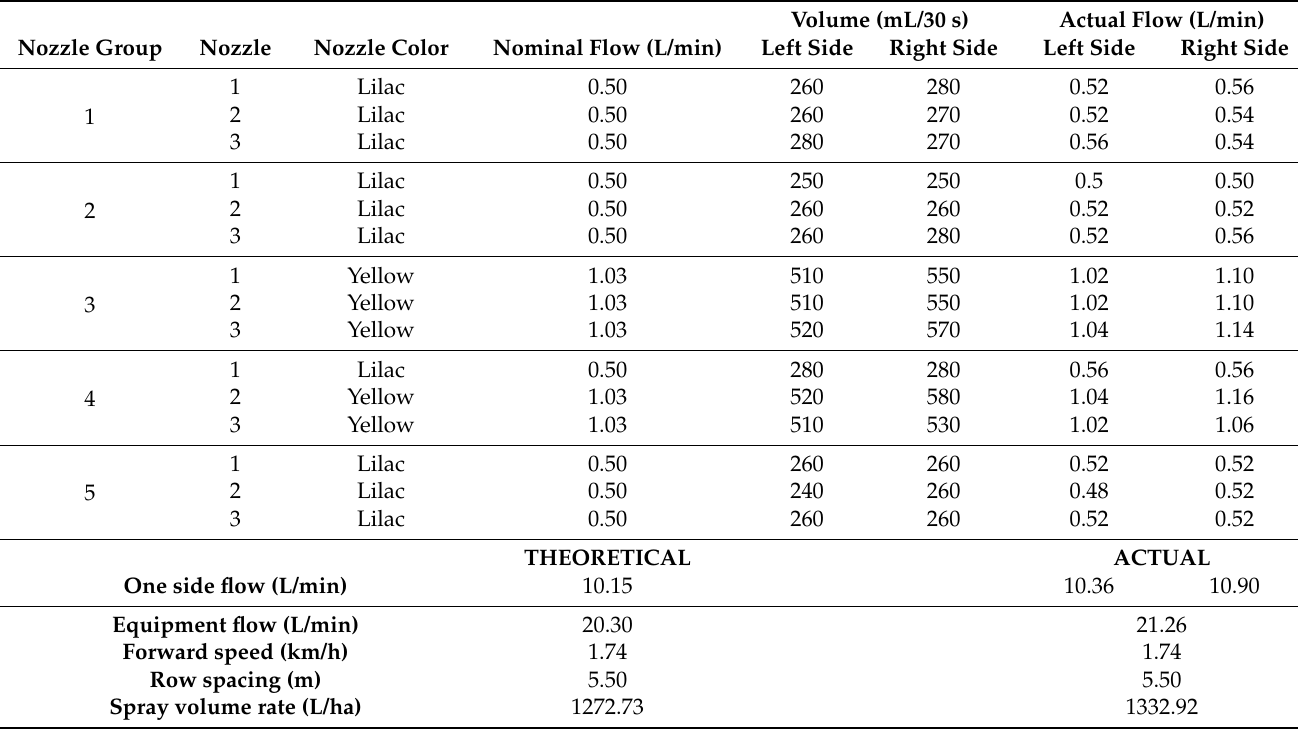
Table A2. Selection and calibration of nozzles for the T sprayer, with the following configuration: No adjusted to the vegetation/High & Low fan speed/Low spray volume rate/Conventional nozzles (Fine)/Pressure: 10